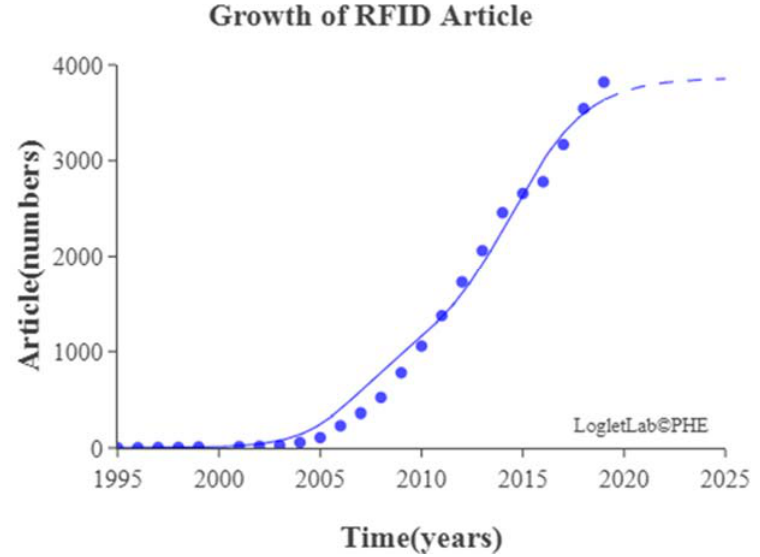
Figure 8. Growth curve of the numbers of papers.